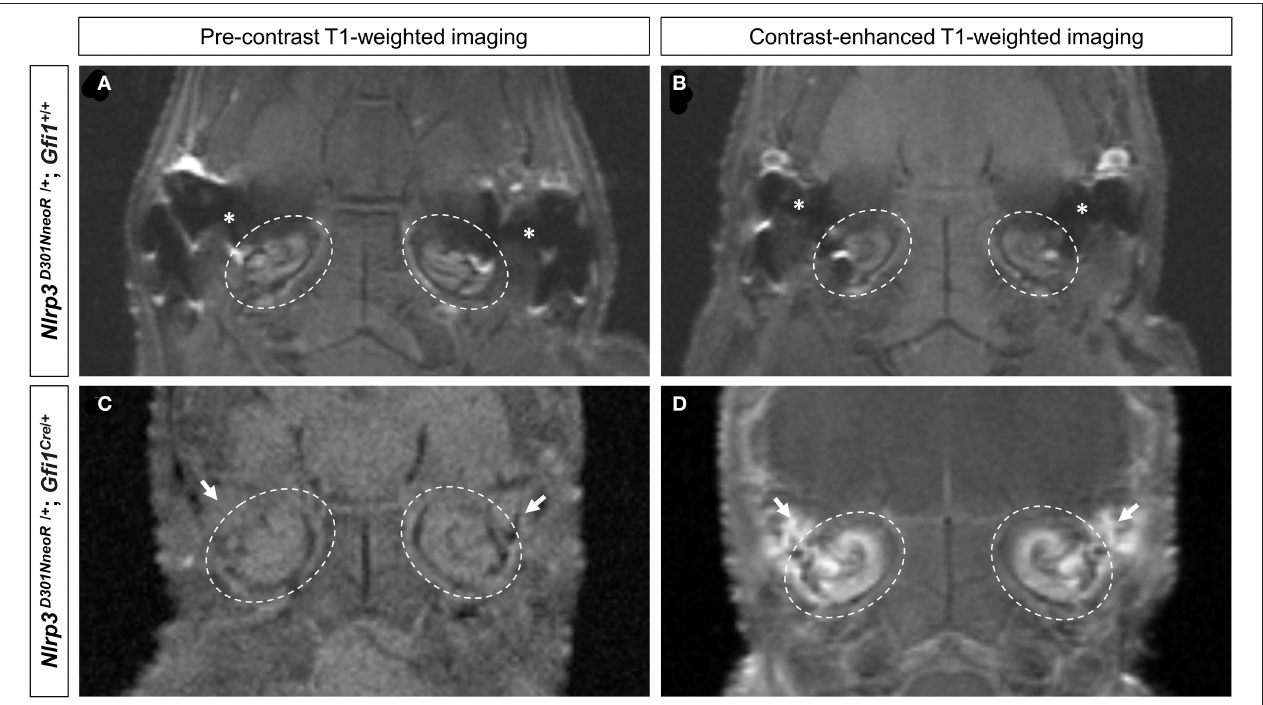
FIGURE 2 | Pre- and post-contrast-enhanced T1-weighted images of the mouse head. Location of the cochlea is shown in dashed circles. The pre-contrast images of both the Nlrp3 D 301 NneoR / + ; Gfi1 + / + (A) and the Nlrp3 D 301 NneoR / + ; Gfi1 Cre / + mouse (C) show similar signal intensity of the cochlea to its surrounding tissue. Images taken 30min after gadolinium injection, show enhancement of the cochlea in the Nlrp3 D 301 NneoR / + ; Gfi1 Cre / + mouse (D) but not in the cochlea of the Nlrp3 D 301 NneoR / + ; Gfi1 + / + mouse (B) . The Nlrp3 D 301 NneoR / + ; Gfi1 Cre / + mouse also has inflammation in the middle ear (white arrows) where in the healthy condition should contain air and appear black as can be seen in the middle ear of the Nlrp3 D 301 NneoR / + ; Gfi1 + / + mouse